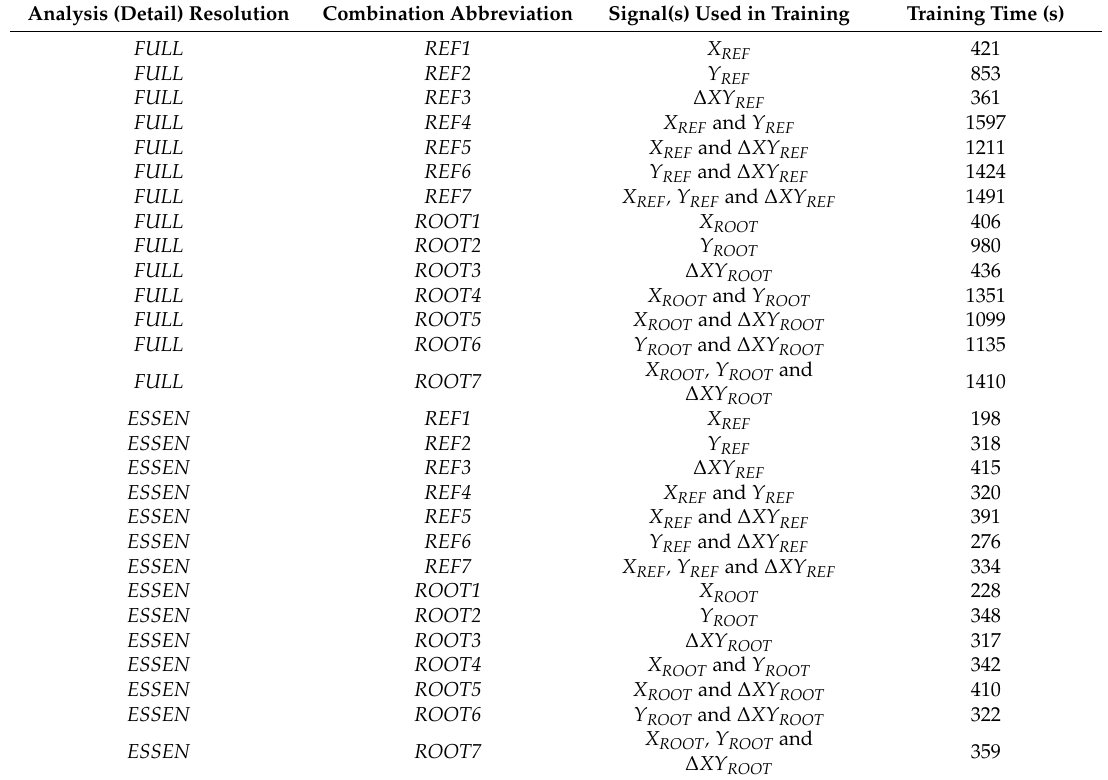
Table 5. Training time of each